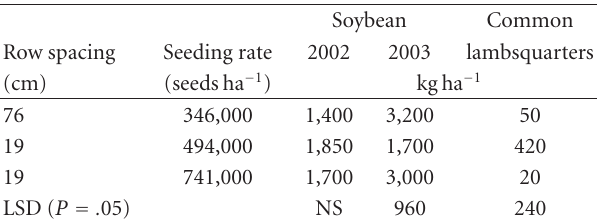
Table 4: E ff ect of soybean row spacing and narrow-row (19-cm) seeding rate on soybean and common lambsquarters fresh weights in 2002 and 2003. Data were combined over years and winter rye seeding rates unless denoted otherwise.